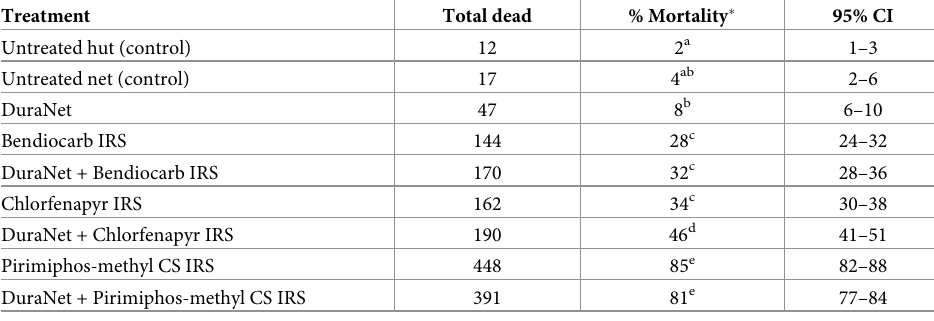
Pirimiphos-methyl CS IRS DuraNet + Pirimiphos-methyl CS IRS � Values in the same column sharing a superscript letter do not differ significantly (P >